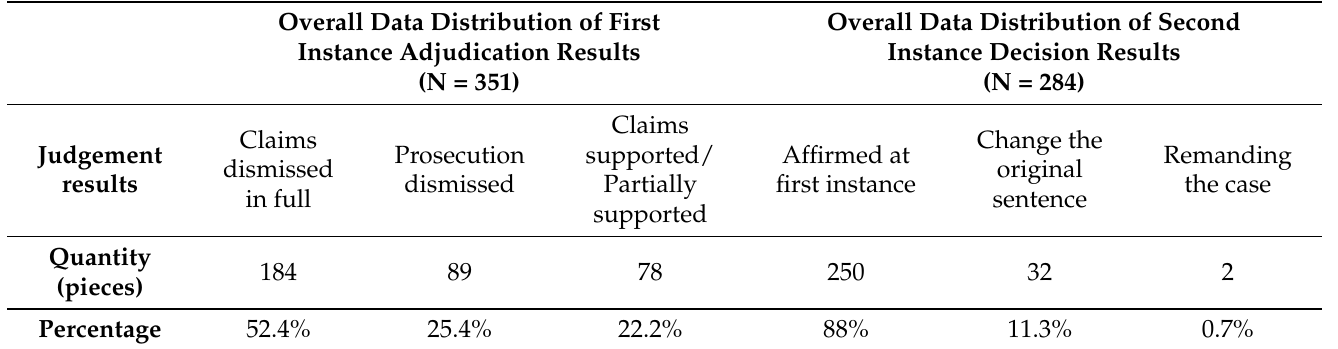
Table 1. Distribution of data on the outcome of judicial decisions (N =